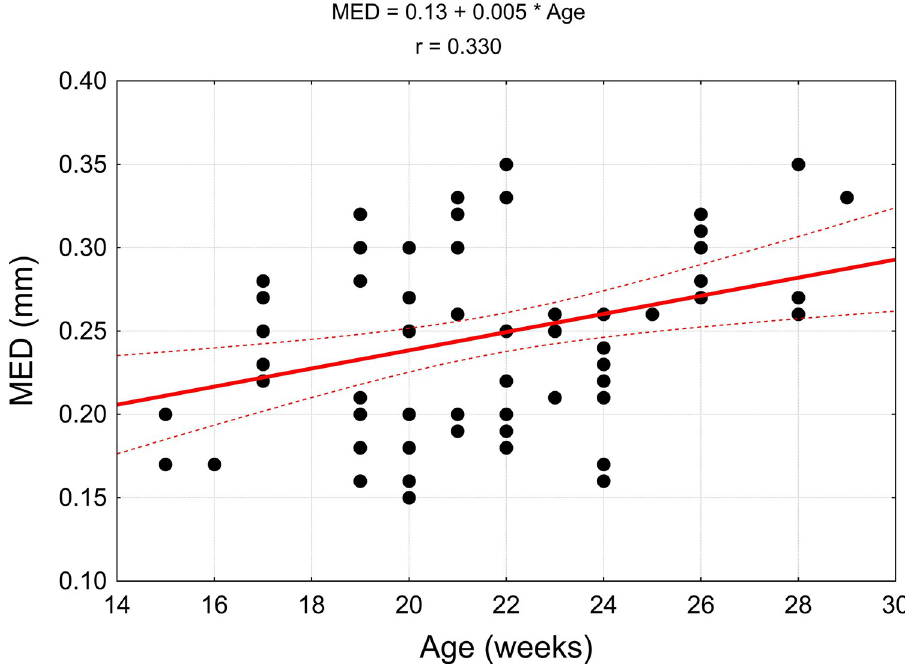
Fig 15. Correlation diagrams for the width of the piriformis muscle (MP) and width of the main branch to the gluteus medius muscle (MED) with the age of the fetus.